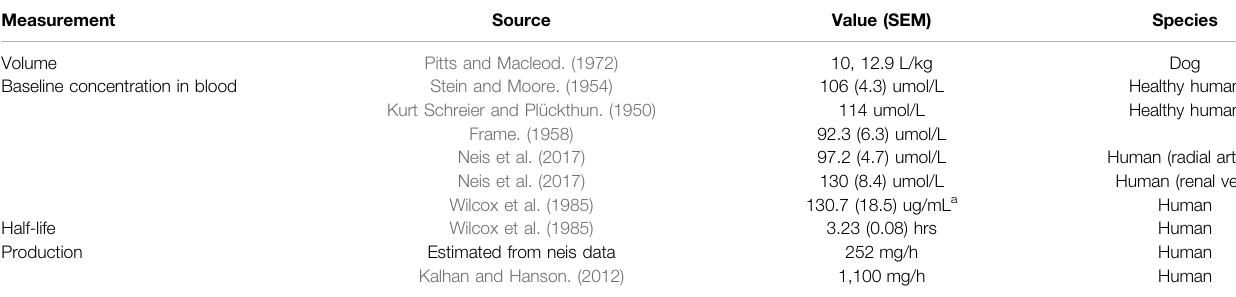
TABLE 1 | Selected serine